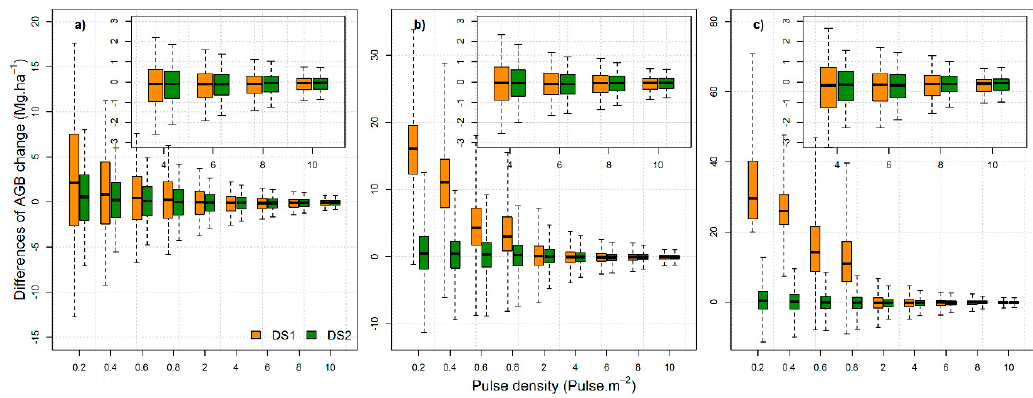
Figure 9. Boxplot of the differences in predicted AGB change at stand level of 12 m − 2 degraded to 0.2, 0.4, 0.6, 0.8, 2, 4, 6, 8 and 10 pulses · m − 2 in areas with slopes ranging from 0 to 12% ( a ), 12–24% ( b ) and 24–36% ( c ), under DS1 (orange) and DS2 (dark green).